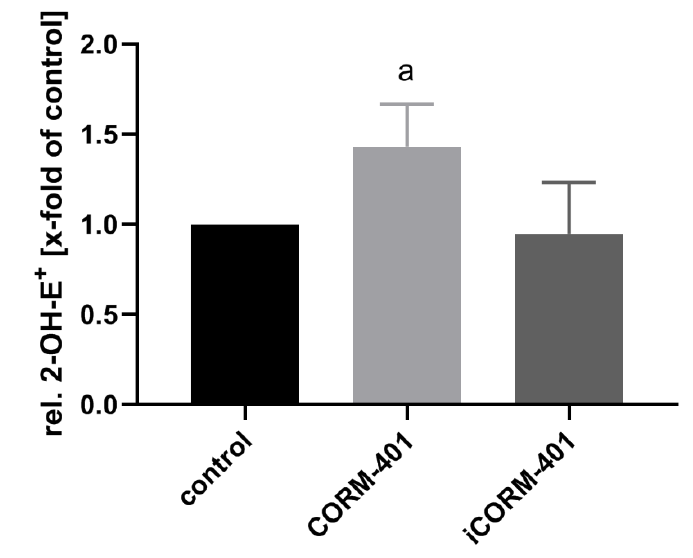
Figure 6. CO from CORM-401 produces a mild oxidative stress. Cells were pre-incubated with 20 µM DHE for 30 min and then treated with 50 µM CORM-401/iCORM-401 for 30 min. Formation of 2-OH-E+ as a marker for superoxide production was monitored using HPLC analysis, quantified via the signal area, and normalized to the total protein amount of cells. Data is given as the relative amount of 2-OH-E+ (control was set to 1) and represents the mean ± SD of three independent experiments (n = 3). Statistically significant differences were evaluated using Student’s t-test with a: control vs CORM-401 and p ≤ 0.05. DHE = dihydroethidium.